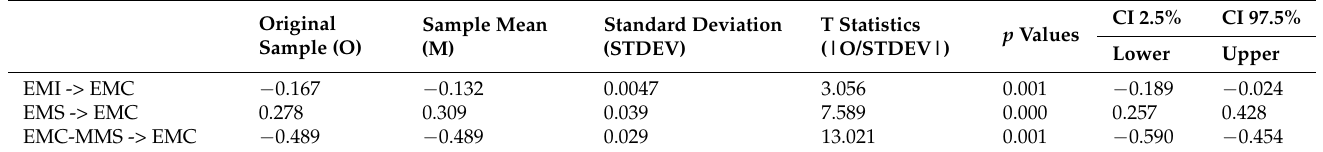
Table A3. Mean, STDEV, T-Values, p -Values, confidence intervals.